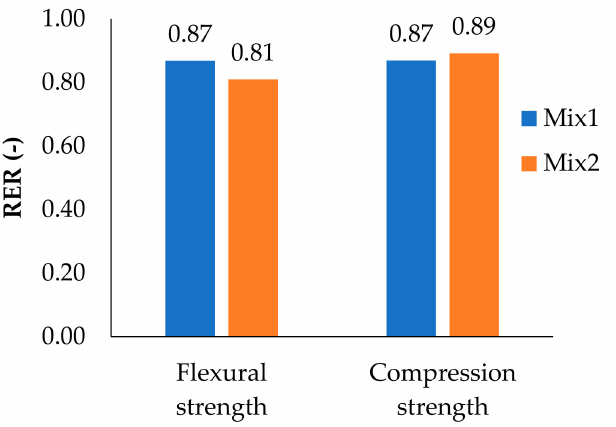
Figure 9. Effect of hemp fibers (RER) on flexural strength and compression strength for NC specimens.